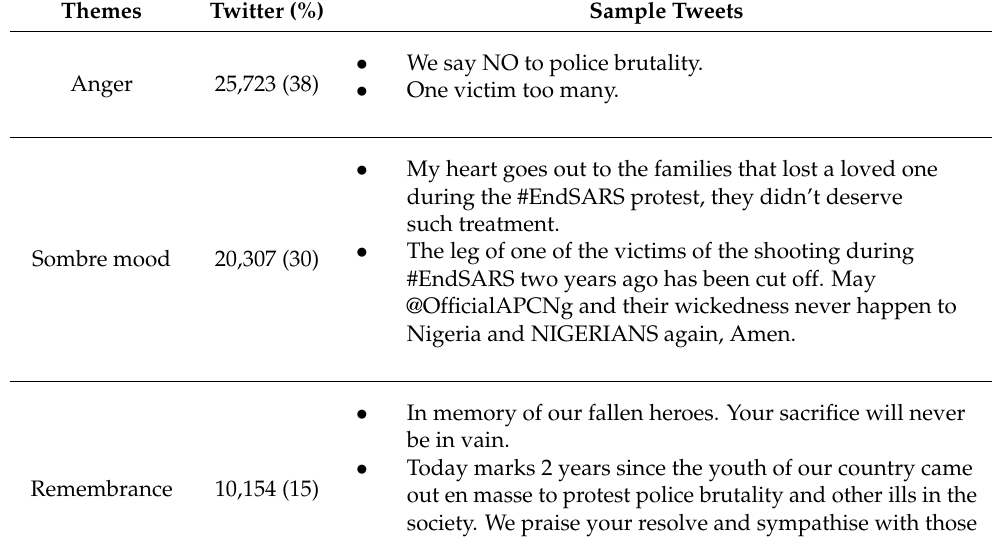
Table 2. Broad themes from the 2022 tweets about the memorial